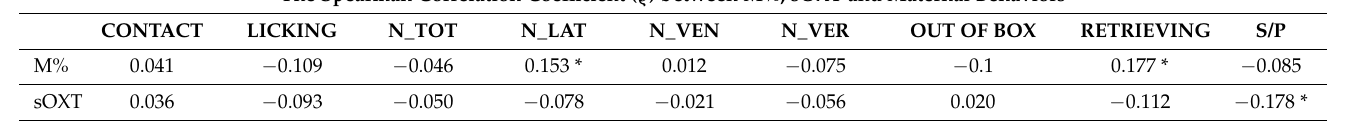
Table 4. The Spearman correlation coefficient ( (cid:36) ) between the percentage of male puppies (M%), sOXT and duration of the observed maternal behaviors: Contact, licking, total nursing (N_TOT) [nursing lateral (N_LAT) + nursing ventral (N_VEN) + nursing vertical (N_VER)], retrieving, sniffing/poking (S/P), and out of box. The Spearman Correlation Coefficient ( (cid:36) ) between M%, sOXT and Maternal Behaviors